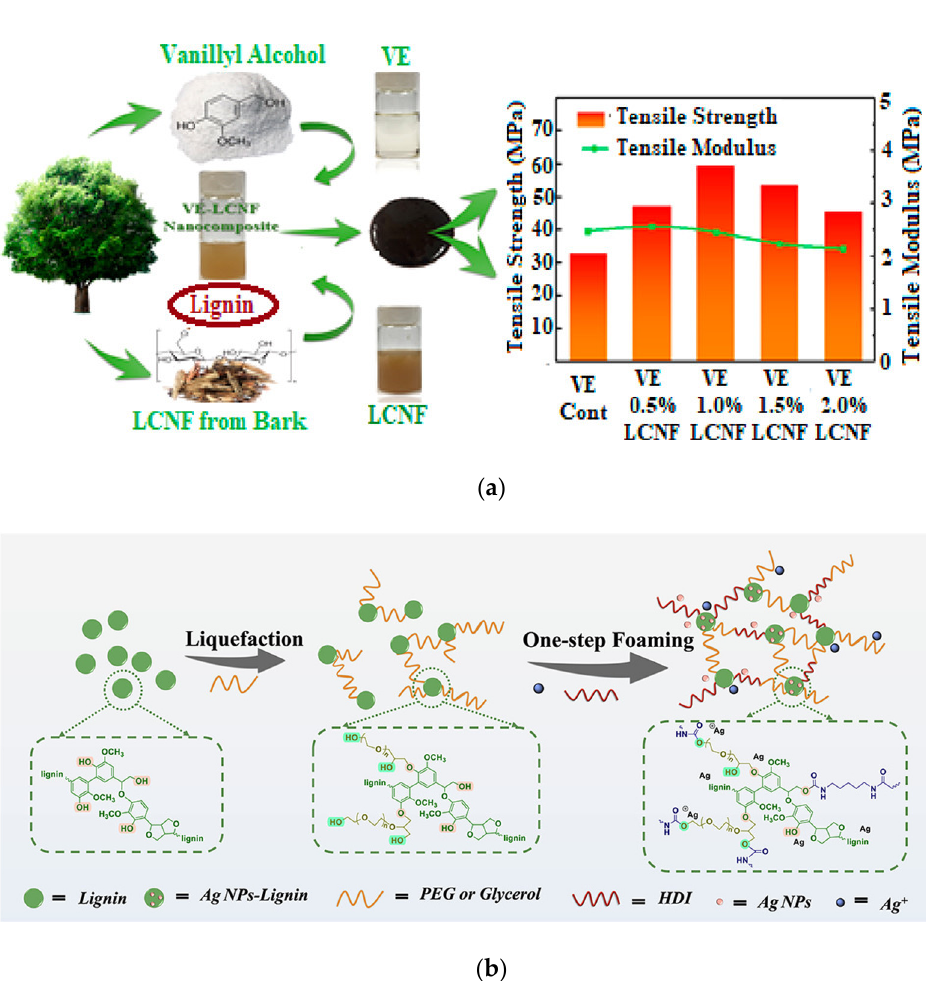
Figure 9. ( a ) Vanillin-based epoxy resin (VE) reinforced with lignin-containing cellulose nanofibrils (LCNFs) and the results of mechanical performance of the nanocomposites produced by considering different LCNF contents; ( b ) Schematic drawing of Ag NP-LPUF composite foam preparation by lignin liquefaction and one-step foaming. Reproduced with permission from [56,58]. Copyright 2020 and Copyright 2022, American Chemical